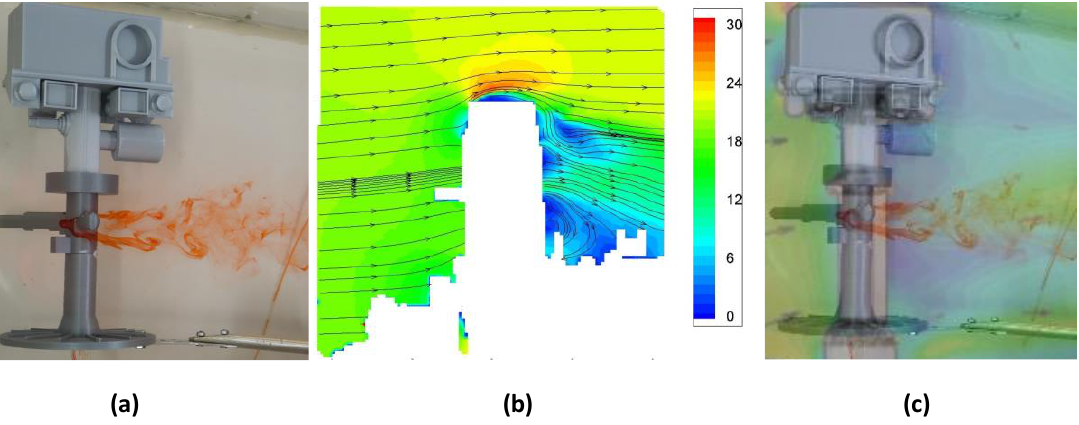
Figure 11. ( a ) Test done in a hydrodynamic towing tank at a slip angle of 90 ◦ ; ( b ) PIV experimental results according to earlier tests; ( c ) overlap of the previous ones.